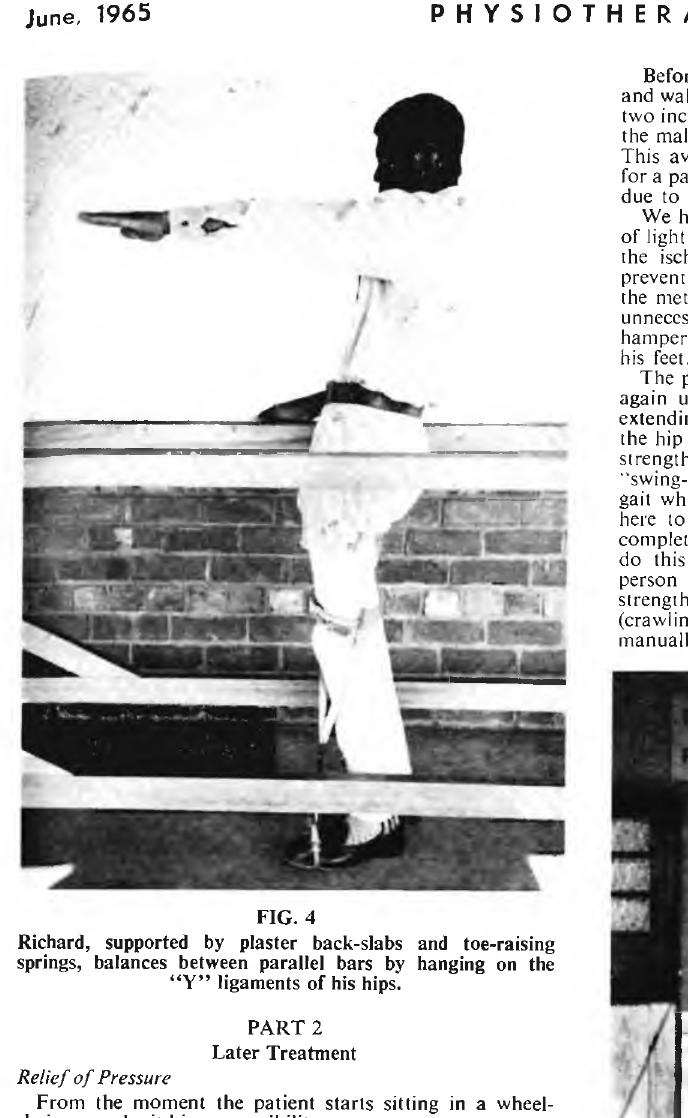
FIG. 4 Richard, supported by plaster back-slabs and toe-raising springs, balances between parallel bars by hanging on the “Y” ligaments of his